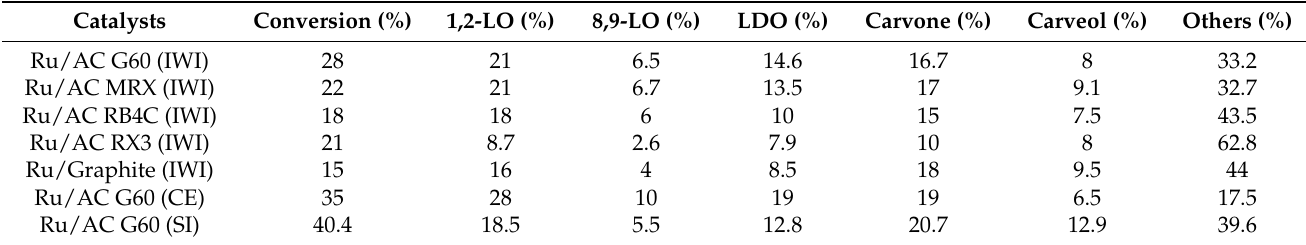
Table 6. Aerobic epoxidation of limonene over supported ruthenium catalysts on activated carbon prepared by different methods